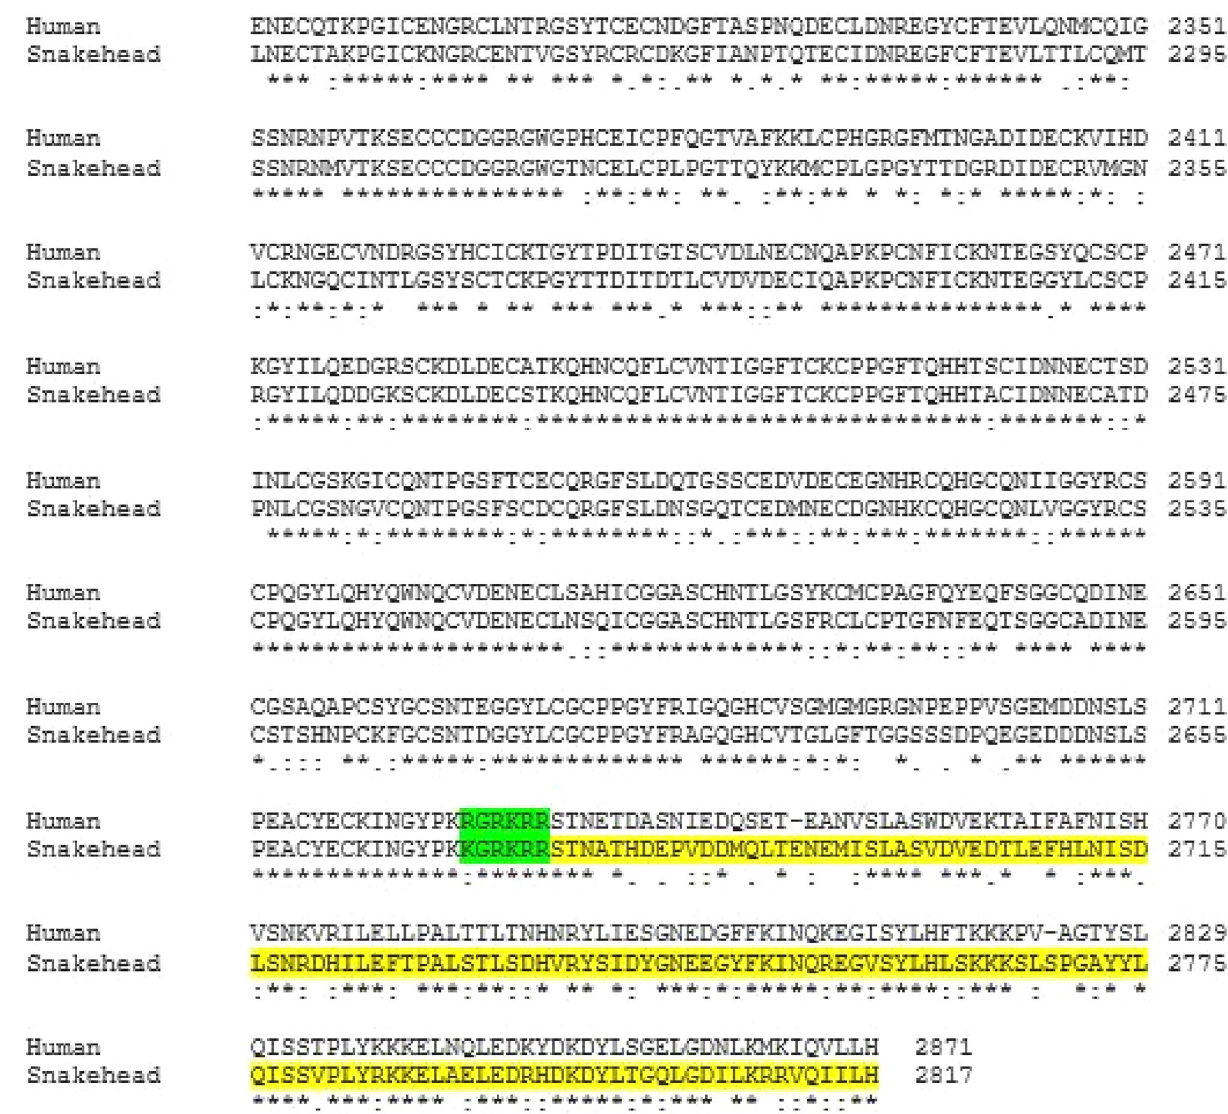
Figure 2. Amino acid alignment of C-terminal region of profibrillin of human and snakehead. The furin cleavage site has been highlighted in green colour and the predicted mature ss asprosin has been highlighted in yellow colour. The ‘*’ represents amino acids that are conserved, ‘:’ indicates amino acids with strongly similar properties, ‘.’ represents amino acids with less similar properties whereas the gaps represent mismatch